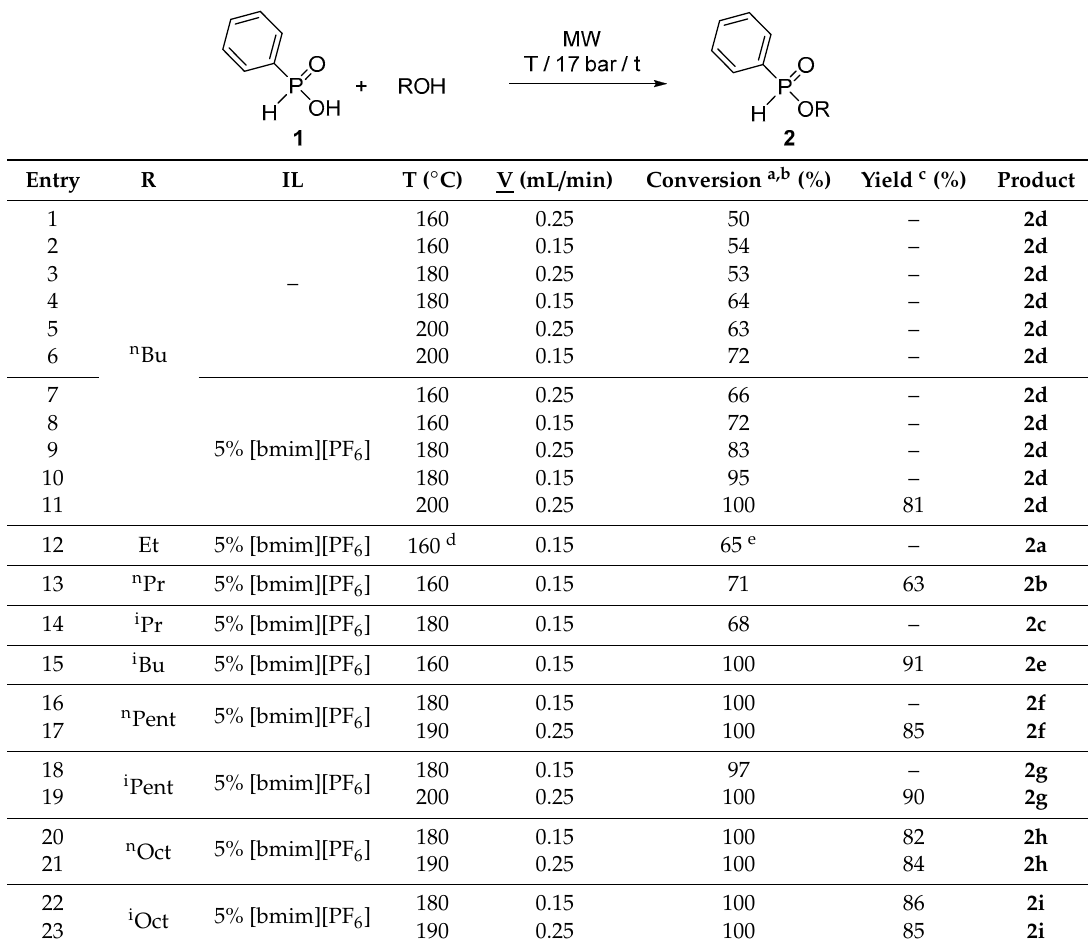
Table 2. Direct esterification of phenyl- H -phosphinic acid ( 1 ) with different alcohols in a flow MW reactor in a concentration of 0.1 g / mL.